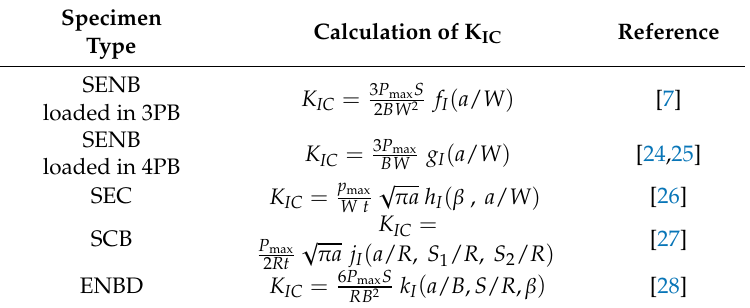
Table 1. Fracture toughness